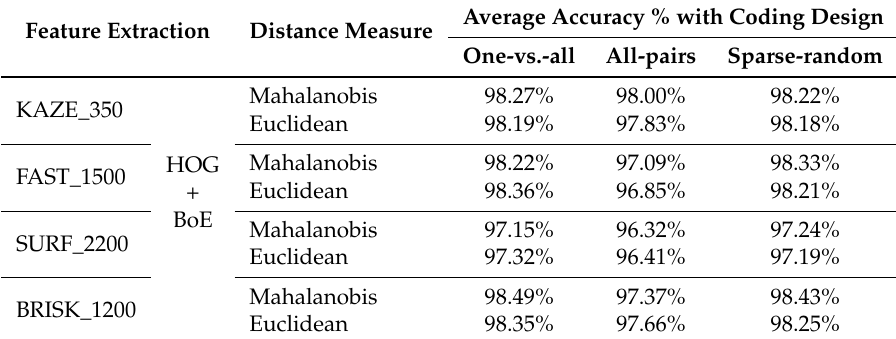
Table 4. Results of bag of expressions-based VMMR approach with the different coding design